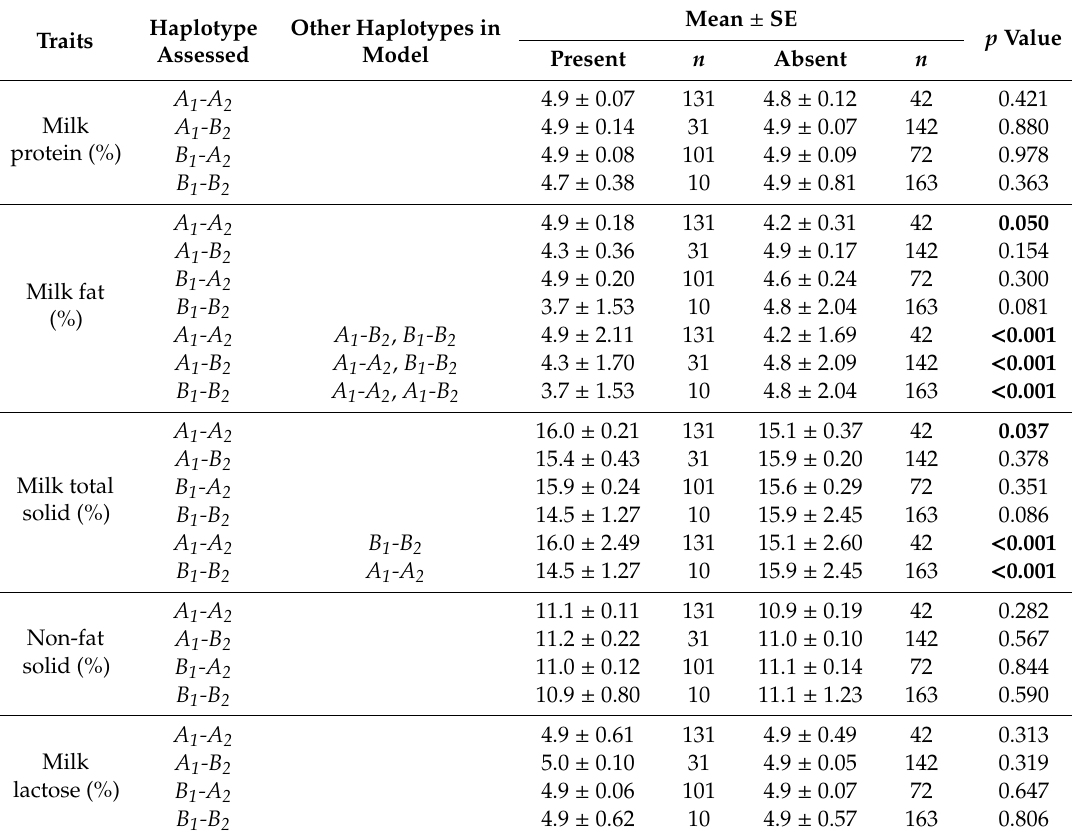
Table 3. Association between the presence / absence of FASN haplotypes and milk traits (Mean ± SE) 1 in Gannan